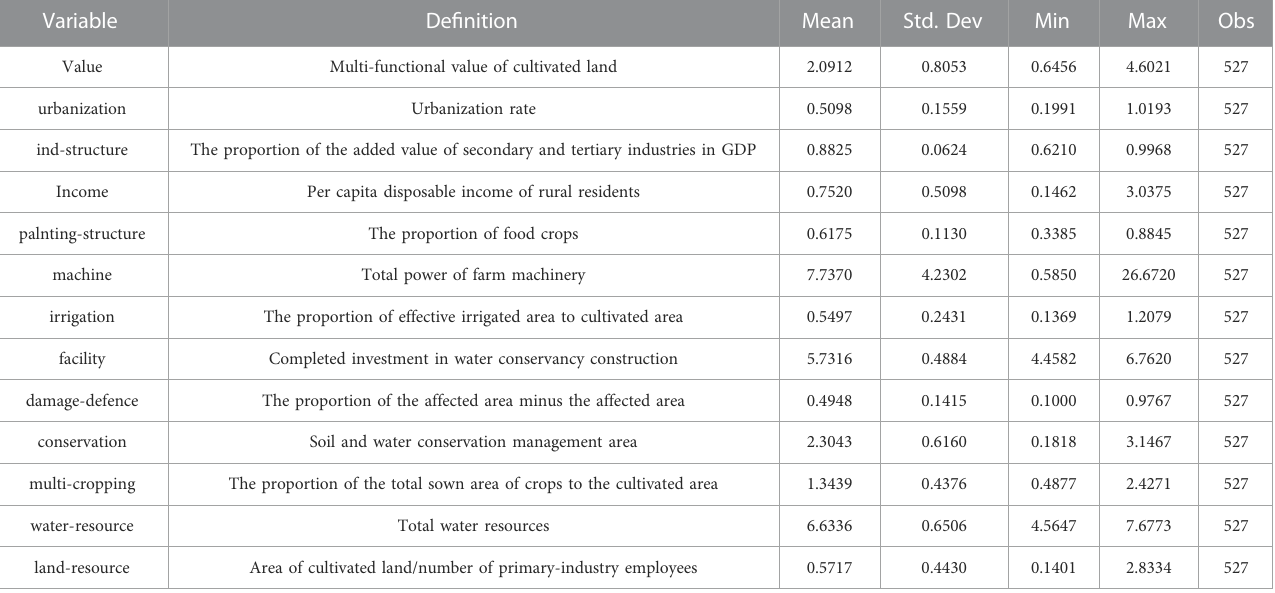
TABLE 2 Descriptive statistical results for each variable. Variable